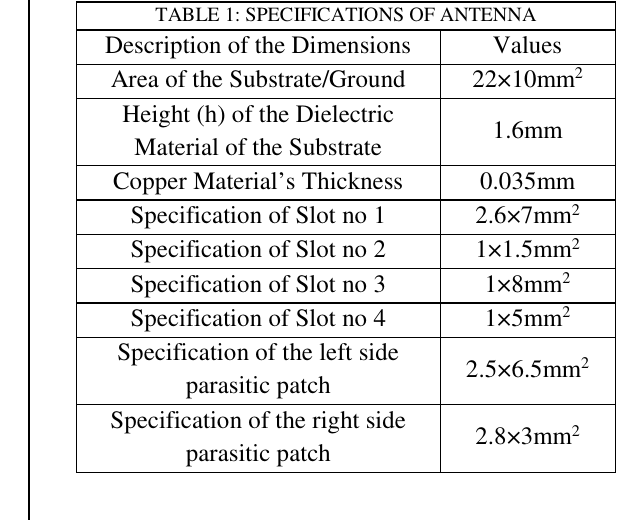
TABLE 1: SPECIFICATIONS OF ANTENNA Description of the Dimensions